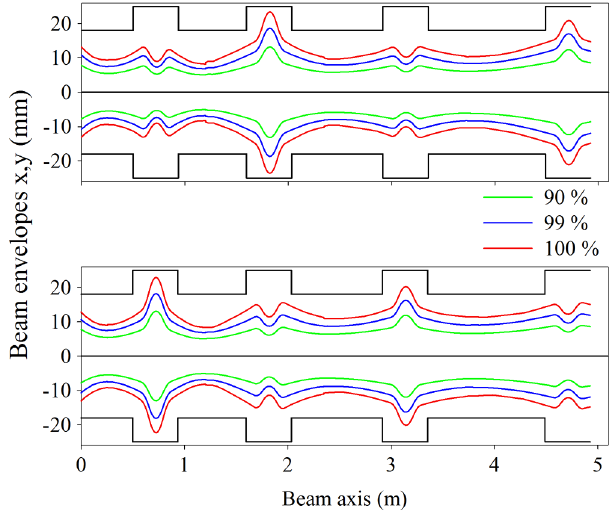
FIG. 23. Transverse 90%, 99%, and 100% envelopes at 500 mA beam current. Black lines indicate the aperture.